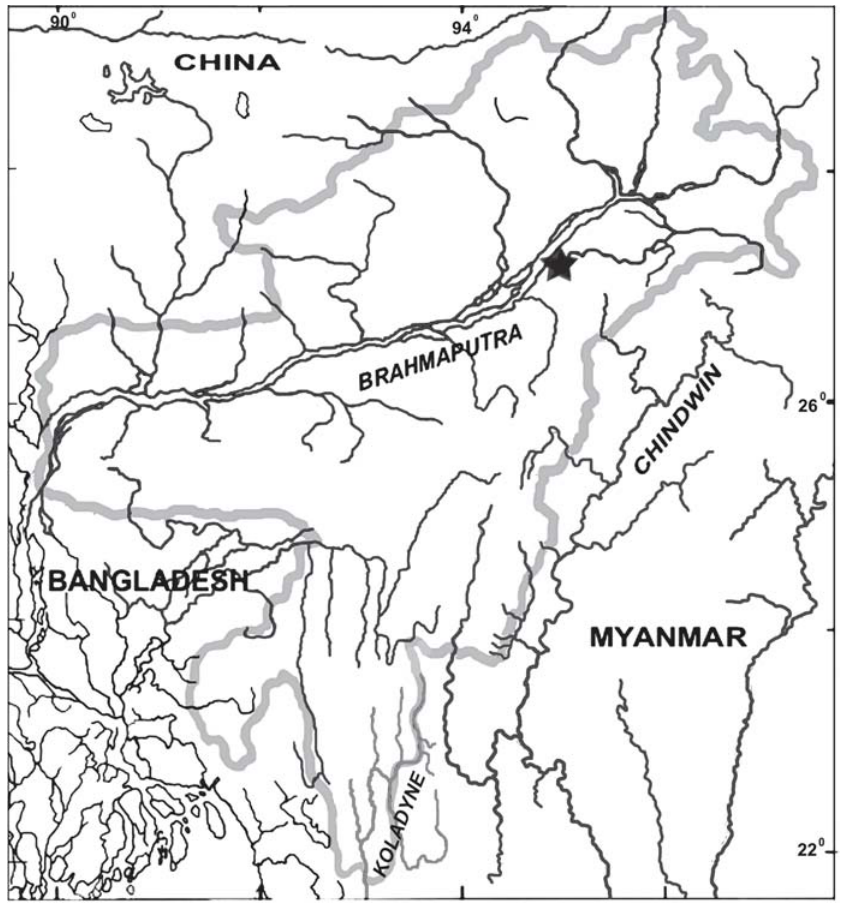
Figure 1. Map showing type locality of Badis dibruensis sp.